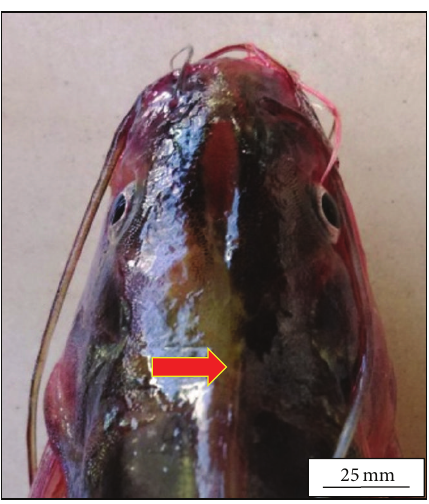
Figure 1: Dorsal view of the head of Mystus tengara showing the posterior extremity of the posterior fontanel (solid red arrow) which extends up to one-third of the supra occipital bone in the adult fish.